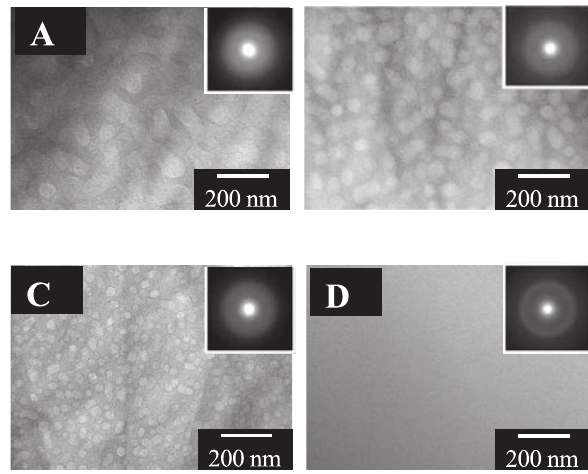
Fig. 3: Transmission electron micrographs of glasses after heat- treating at 948 K for 192 h [2].